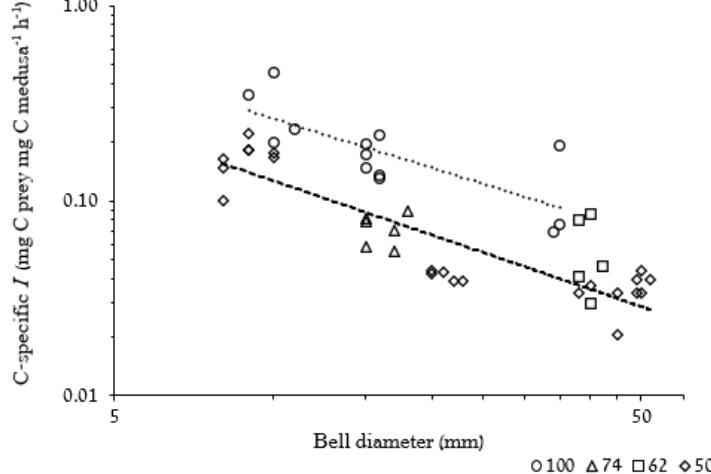
Figure 7. Log–log plot of carbon-specific ingestion rate (C-specific I ) against BD ( n = 46). Similar prey concentrations are presented under the same legend values as follows: 50 ( n = 22) = 50 and 53 Artemia L −1 , 100 ( n = 13) = 97, 99 and 100 Artemia L −1 . Dashed curve line for 50 prey L −1 and dotted curve line for 100 prey L −1 . C-specific I (50 prey L −1 ) = 1.065*BD −0.92 , R 2 = 0.811, F 1, 20 = 89.8, p < 0.001. C-sp I (100 prey L −1 ) = 1.828*BD −0.84 , R 2 = 0.584, F 1, 11 = 15.1, p < 0.05.